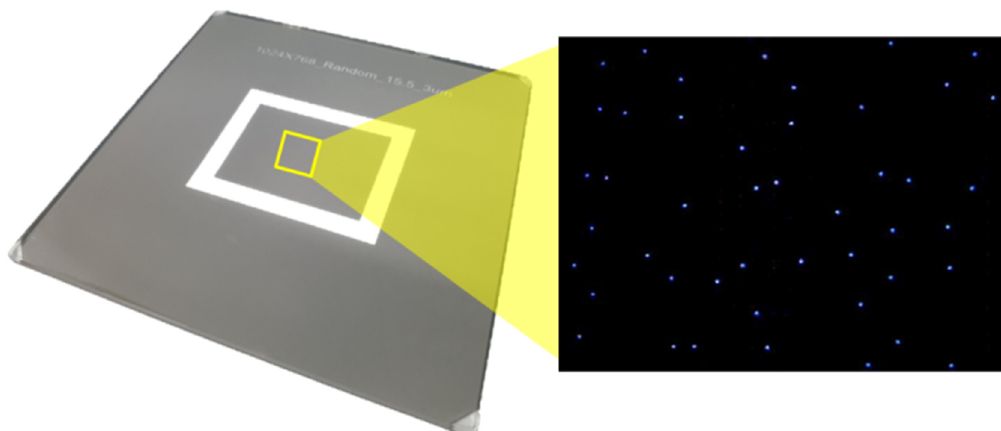
Figure 6. Magnified image of the custom-made non-periodic pinhole array filter.